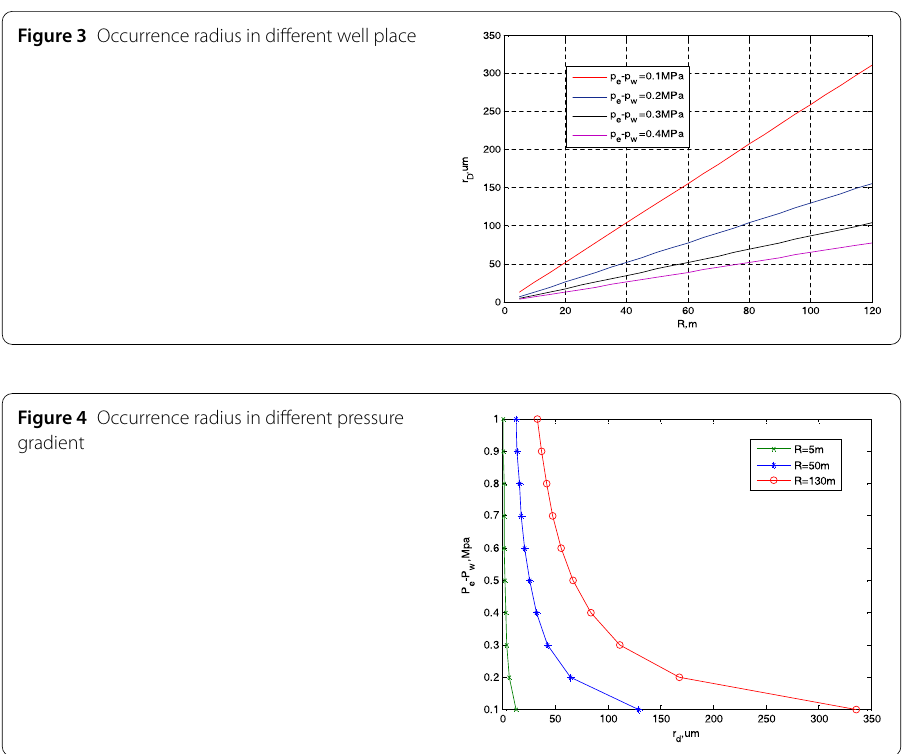
Figure 3 Occurrence radius in different well place